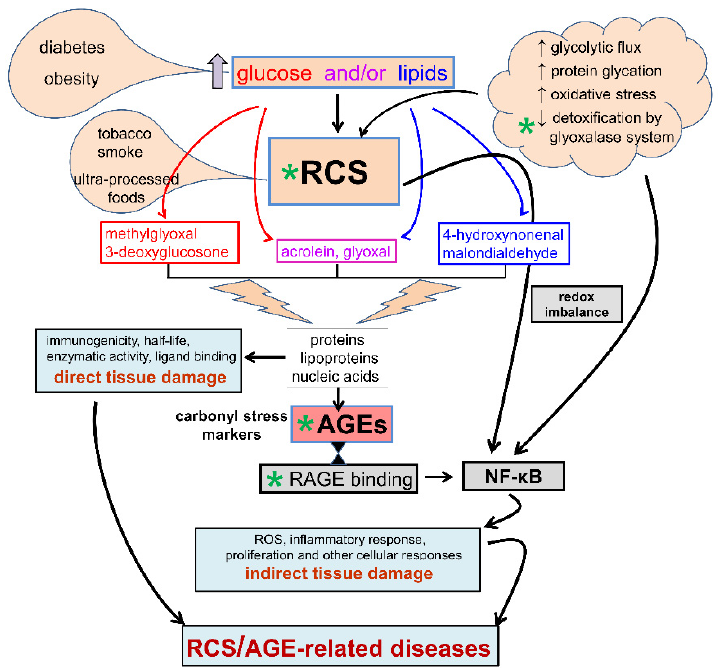
Figure 2. Carbonyl stress. Causes and mechanisms of reactive carbonyl species (RCS) and advanced glycation end-products (AGEs) formation, pathogenetic mechanisms in carbonyl stress-induced tissue damage, and potential drug targets (green asterisk). NF- κ B = nuclear factor- κ B; ROS = reactive oxygen species.